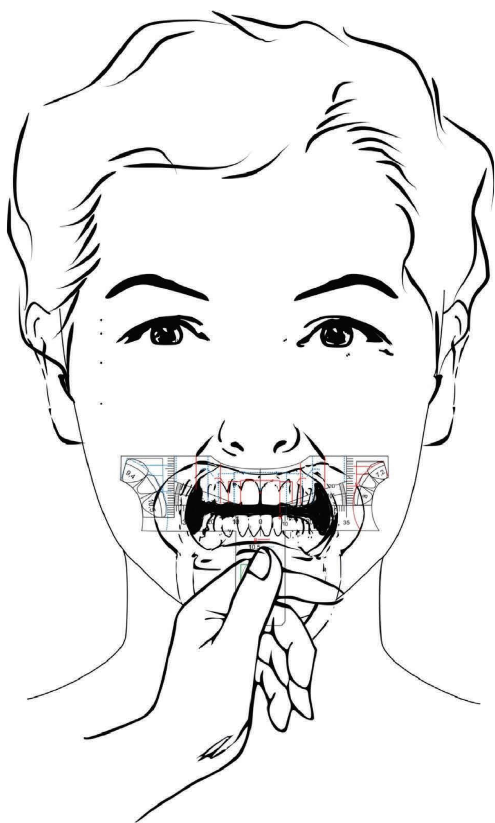
Figure 7: Frontal view illustration of the invention handling golden proportion analysis.